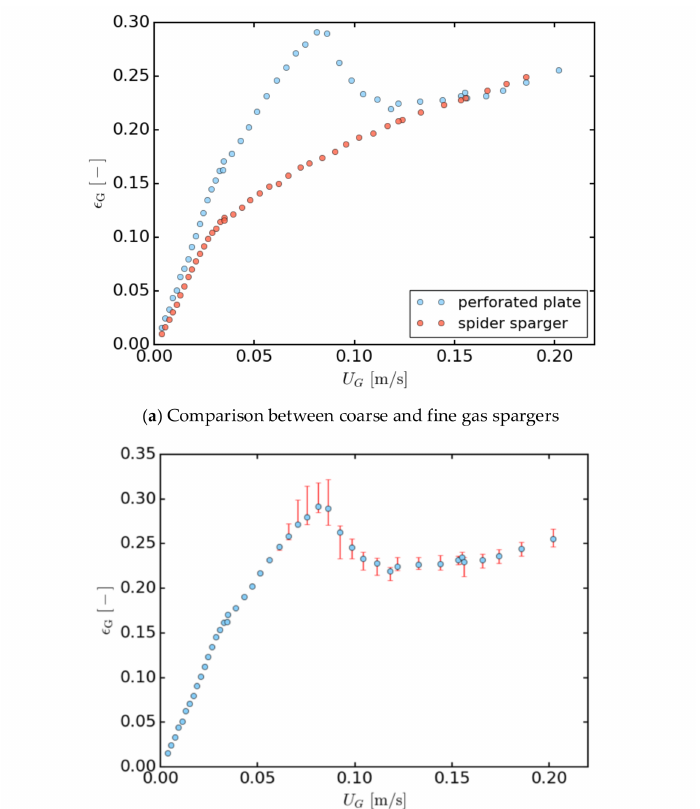
Figure 13. Flow regime maps.